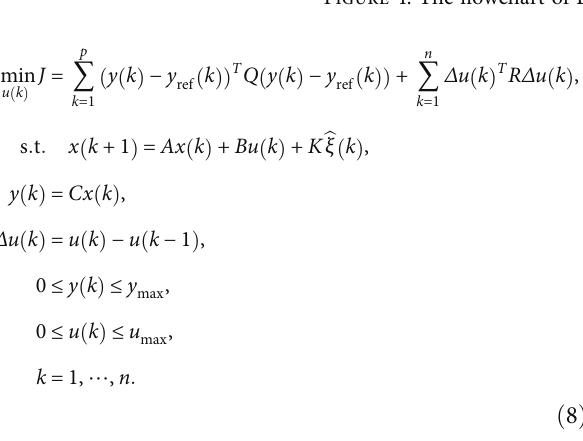
Figure 4: The fl owchart of DL-based real-time MPC for